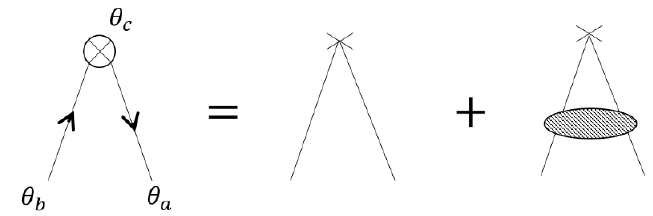
. A cross denotes a J insertion, and the shaded area J ¯ΦΦ (cid:31) (cid:30)